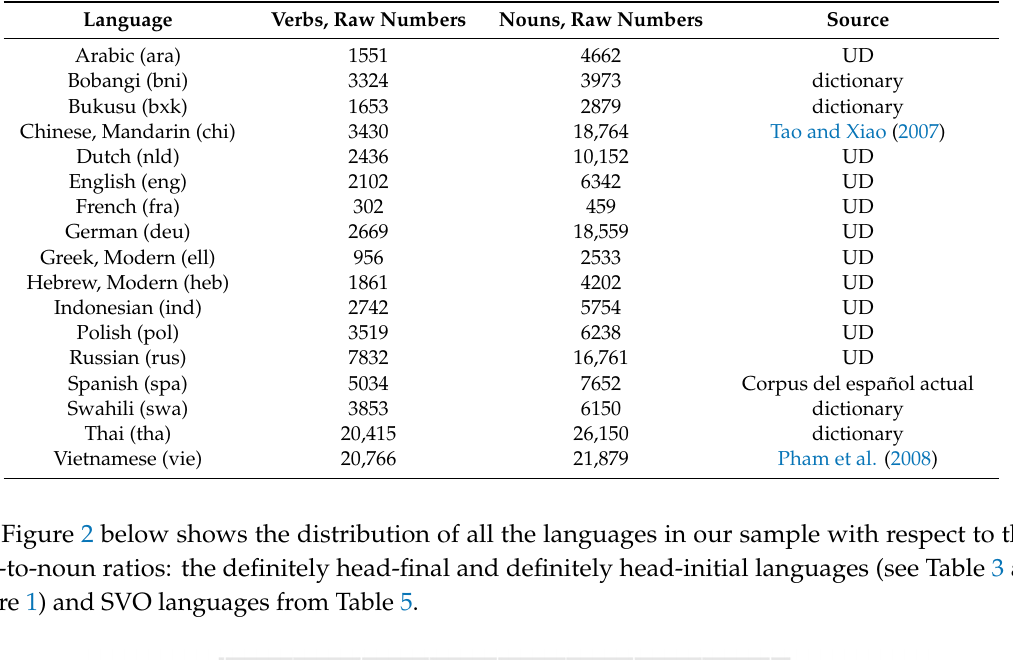
Table 5. SVO languages: Verb-to-noun ratios.